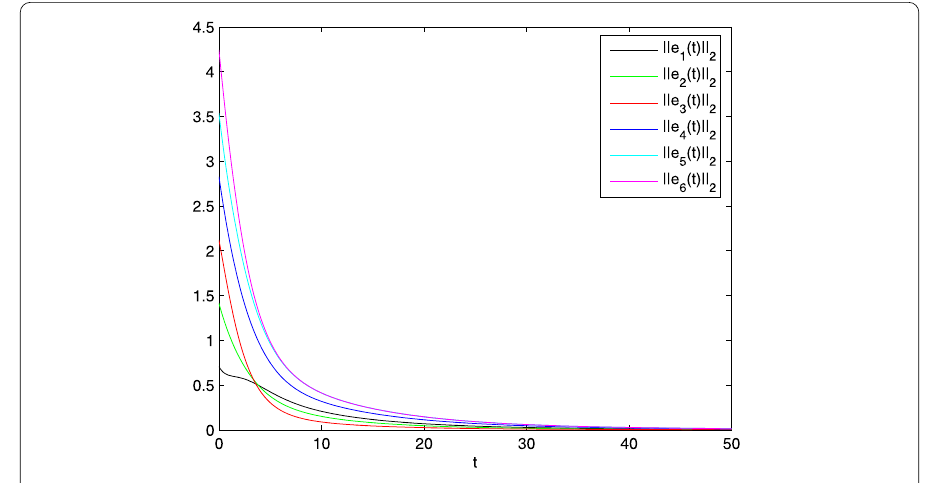
Figure 3 The synchronized error (cid:2) e i ( t ) (cid:2) 2 , i = 1,2,3,4,5,6, of system (32) under adaptive control (11).